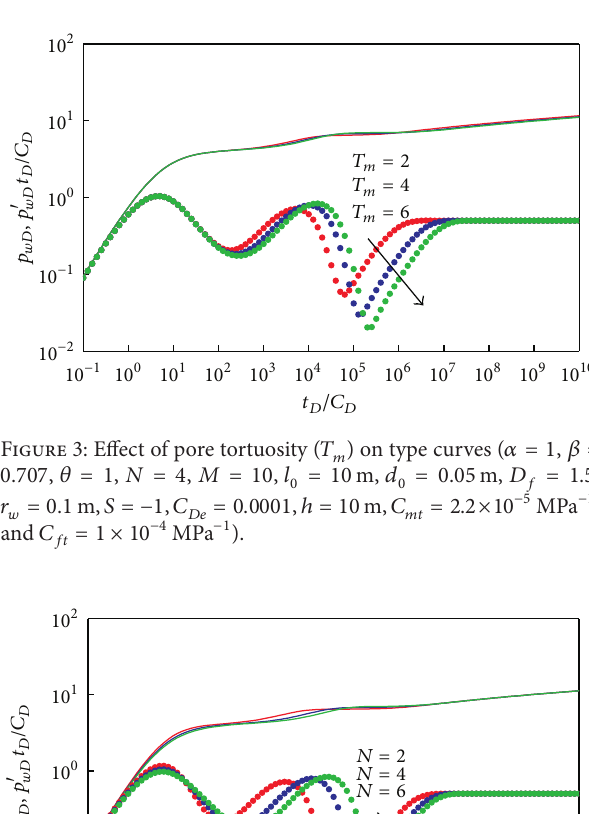
= 10 m, 𝑑 = 0.05 m, 𝐷 = 1.5 , 𝑇 = 4 , 0 0 𝑓 𝑚 = 0.0001 , ℎ = 10 m, 𝐶 = 2.2×10 −5 MPa −1 , 𝐷𝑒 𝑚𝑡